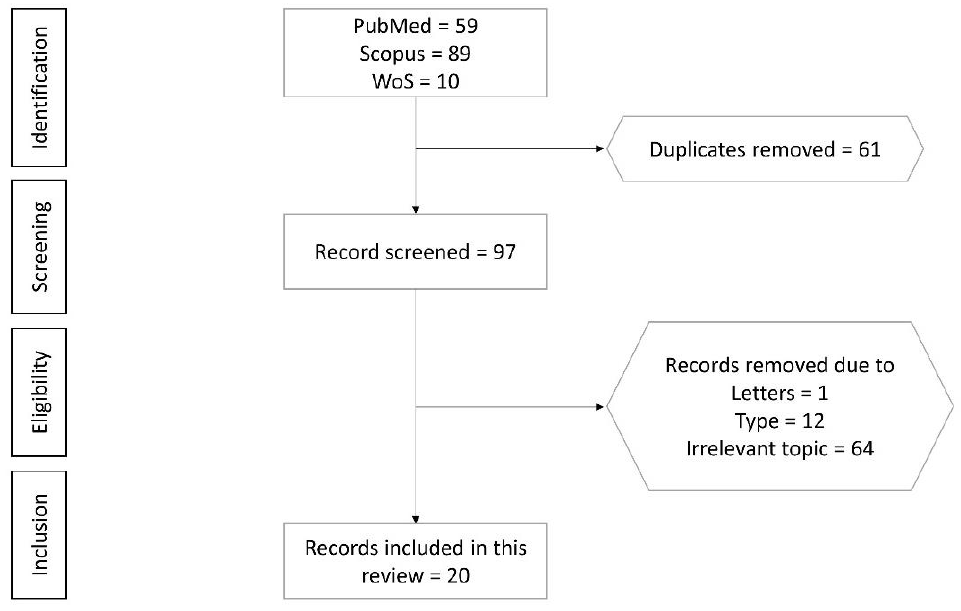
Figure 1. Flowchart of the article selection process.